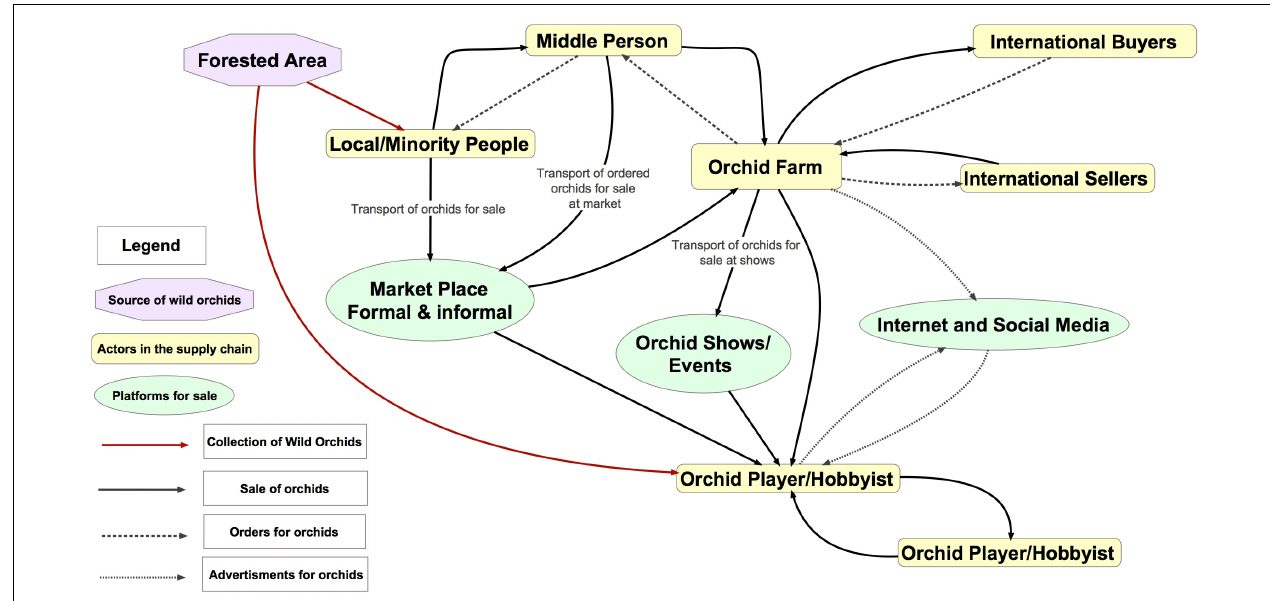
FIGURE 1 | Conceptualisation of the supply chain of orchids including the flow of goods, orders for those goods and advertisements for those